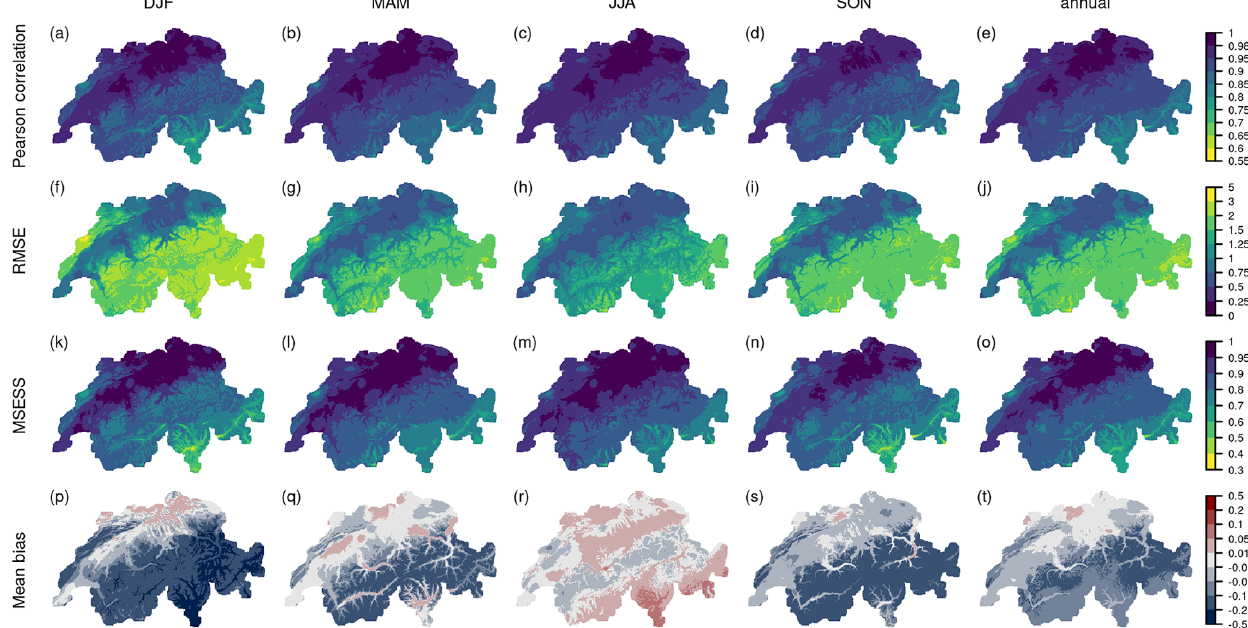
Figure 3. Cross-validation results of a network of 32 stations as in Fig. 1c for temperature anomalies during 1961–2020 for the four seasons (DJF, MAM, JJA, SON) and annually. (a–e) Pearson correlation, (f–j) RMSE, (k–o) MSESS, and (p–t) mean bias.